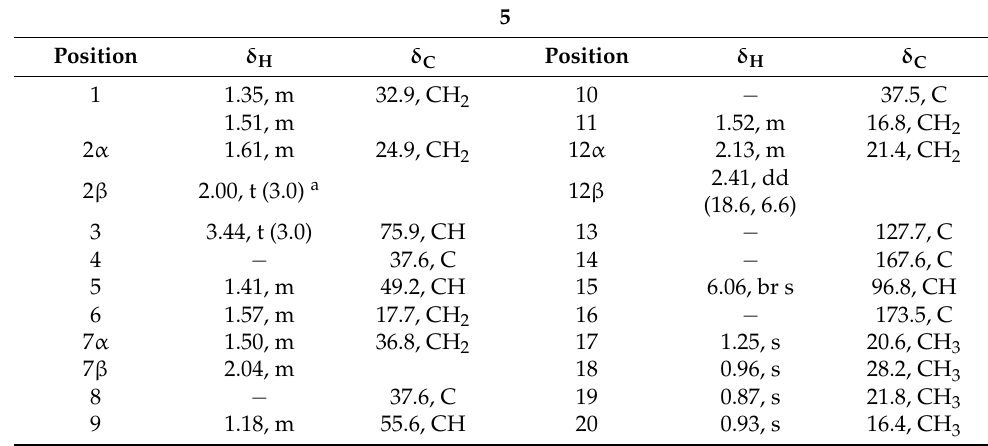
Scheme 1. A plausible biosynthetic pathway for the formation of structures 1 – 5 . Table 2. 13 C and 1 H NMR data for compound 5 (150/600 MHz) in CDCl 3